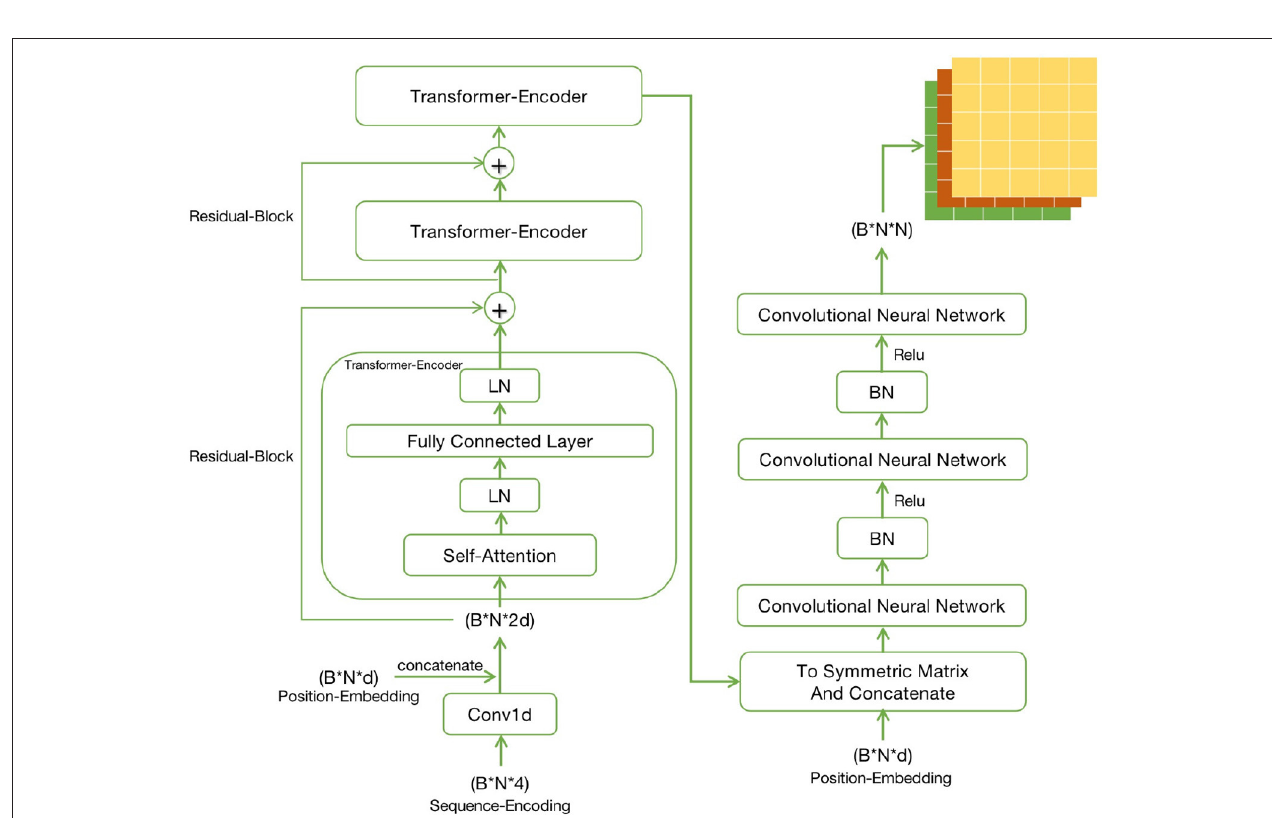
FIGURE 2 | Detailed diagram of Encoder network and Decoder